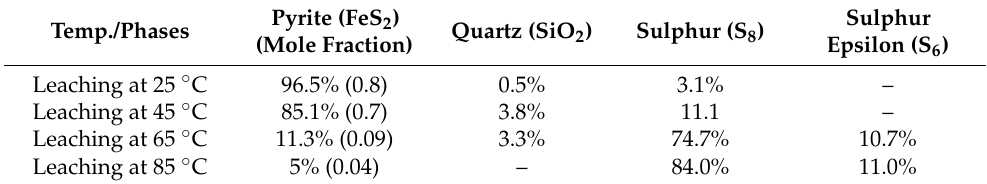
Table 2. The XRD Rietveld refinement for different temperatures. Temp./Phases